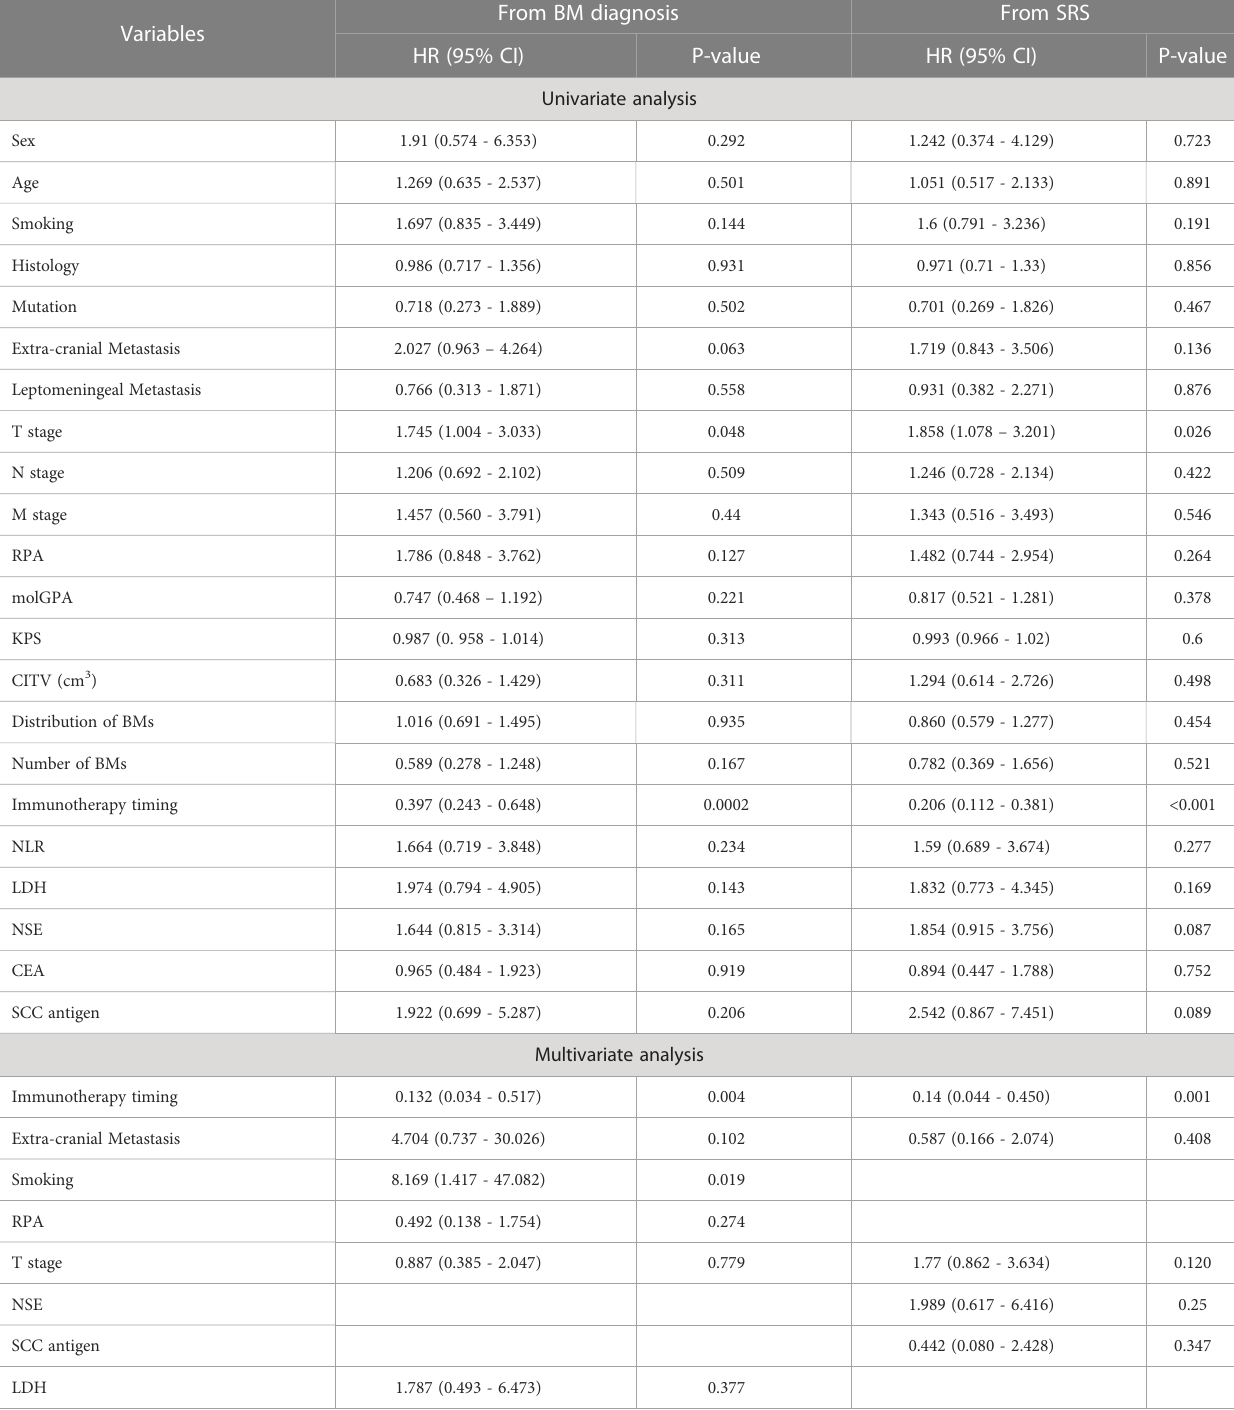
TABLE 4 Univariate and multivariate analysis for overall survival in NSCLCBM patients treated with SRS plus